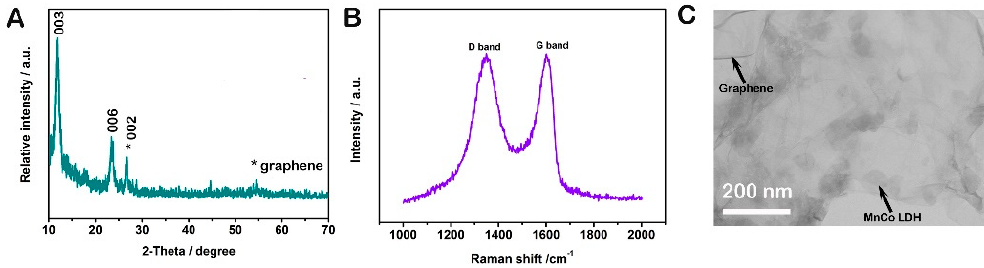
Figure 2. ( A ) XRD pattern of MnCo-G; ( B ) Raman spectrum; ( C ) TEM image of MnCo-G.